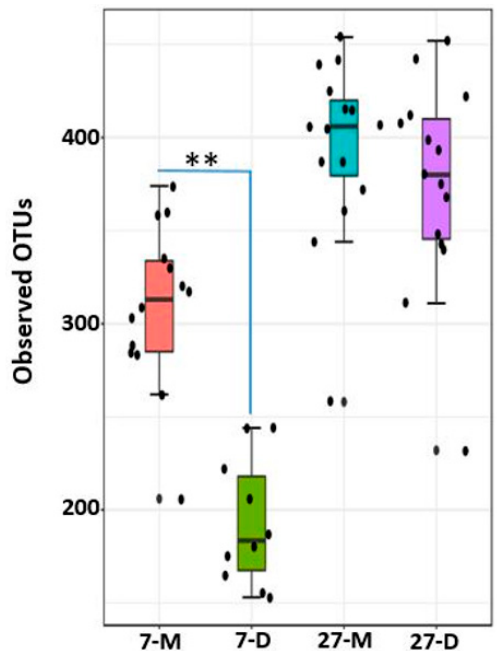
Figure 8. Alpha diversity between two post-weaning ages as measured by Observed_OTUS metric. *** represents significant difference between two groups at p < 0.0001. The 7 and 27 represent 7 and 27 days, respectively, after weaning. Increase in post-weaning age resulted an increase in alpha diversity.